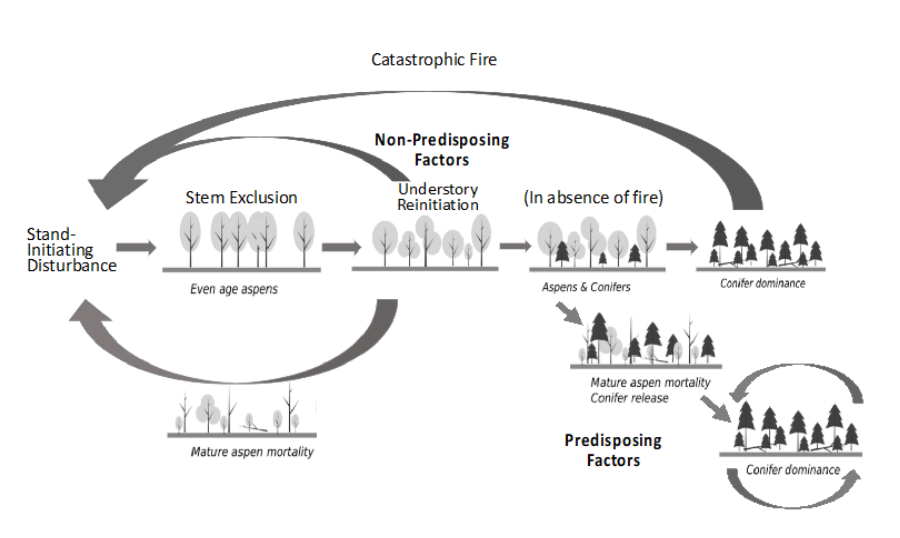
Figure 1. Possible successional trajectories of aspen stands in the Rocky Mountains. Aspen develops as even-aged stands following a large-scale initiating disturbance. Following stem exclusion understory re-initiation will produce suppressed suckers and an herbaceous ground story [26]. In fertile sites where aspen can self-perpetuate, or in the presence of some intense disturbance, such as fire, stands return to initiation. In the absence of fire, conifer encroachment can convert the stand, either permanently (self-perpetuating conifer stand in the bottom right corner—usually facilitated by conditions suited to SAD), or temporarily, returning to seral aspen following another stand-replacing fire. Conifer species can vary across the range of aspen, including lodgepole and juniper in drier sites, and spruce and fir at higher